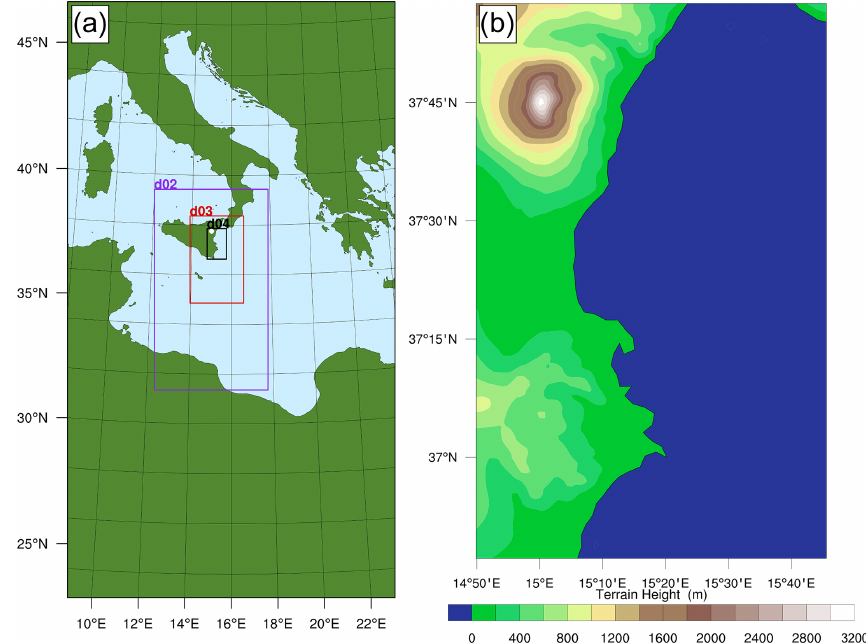
Figure 3. (a) The WCV model area; d02 , d03 , and d04 are progressively nested domains with two-way nesting. (b) Terrain elevation in d04 .